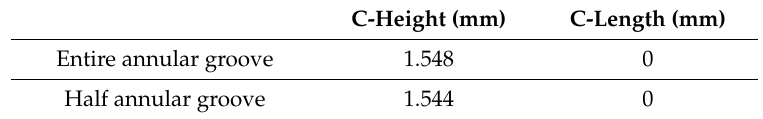
Table 1. Characteristic size of the droplet in the entire annular groove and half annular groove.